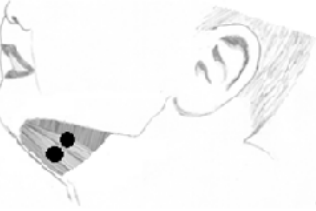
Figure 1. Suprahyoid muscles. Schematic illustration of the muscles analyzed in this study and the location of the surface electromyography electrodes.